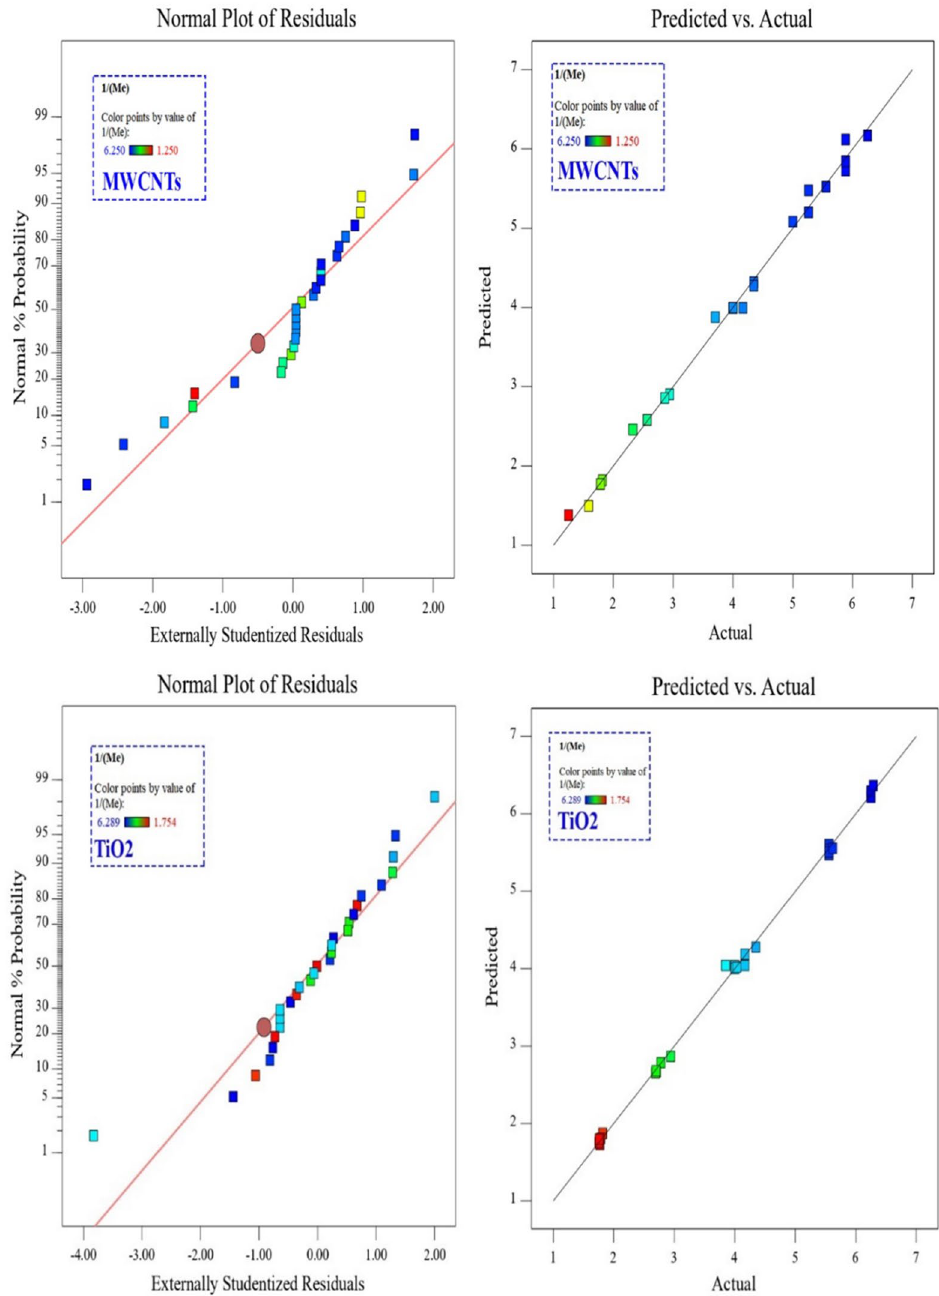
Figure 14. The normal residual diagrams of TiO 2 and MWCNTs nanofluids comparing the expected Merkel number and experimental